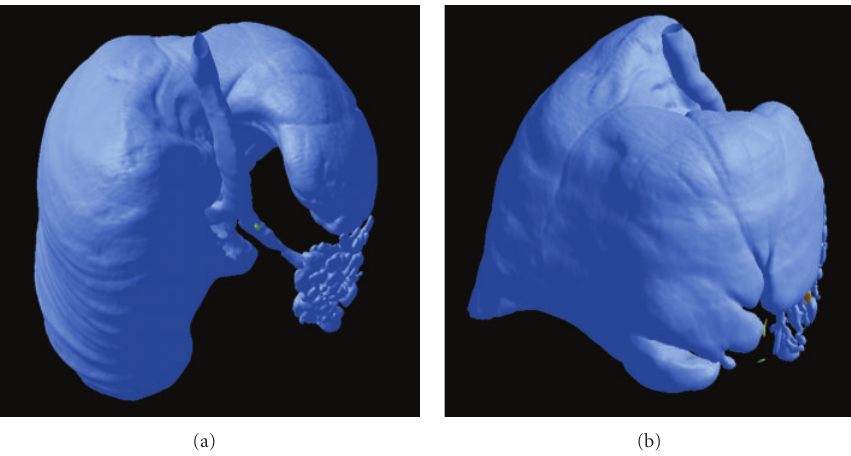
Figure 4: 3D Reconstructions in the “surface” mode visualize both the hypoplastic dysplastic left lung, with multicystic architecture of small range segmentation (a), and the right hypertrophic lung with the pleural fissures and the abnormal lobar orientation (b). The upper lobe is in the left-posterior location, the middle lobe is in the left-anterior position, and the lower lobe is emptying the retrosternal space and the right hemithorax. The mediastinal space is reduced and posterior located, surrounded by the “horseshoe” right lung.